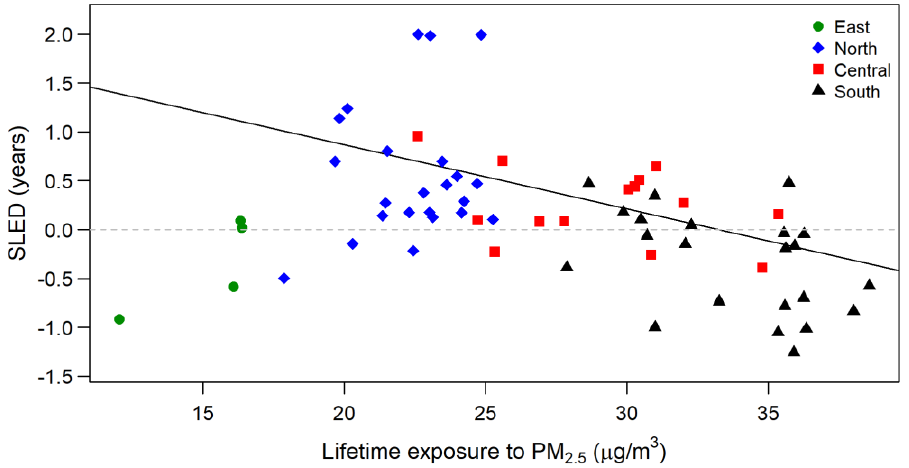
Figure 2. Standardized life expectancy deviation plotted against expected lifetime exposure to particulate matter (PM 2.5 ) for the cohorts in the 63 study areas, which are marked with four different shapes to indicate cohorts located in eastern, northern, central and southern Taiwan. The slope of the added solid line is −0.066.